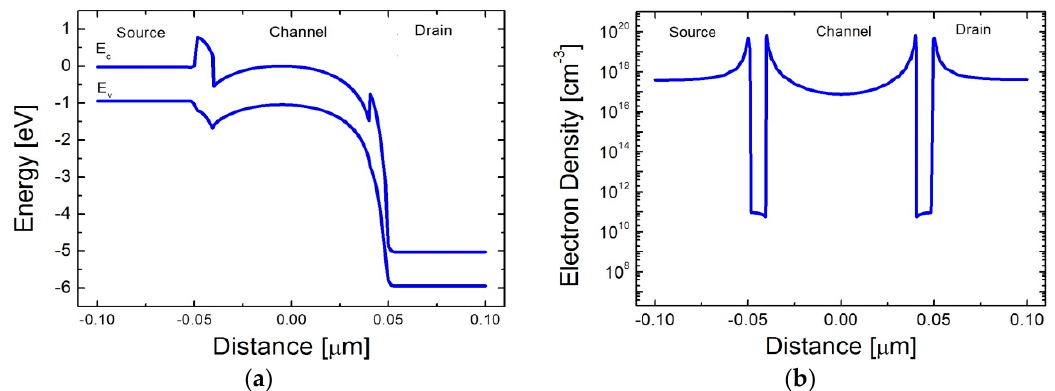
Figure 4. Verification of erase operation. ( a ) Energy-band diagram along the channel direction under the erase bias condition at 500 K; ( b ) Electron concentration after erase operation at 500 K.